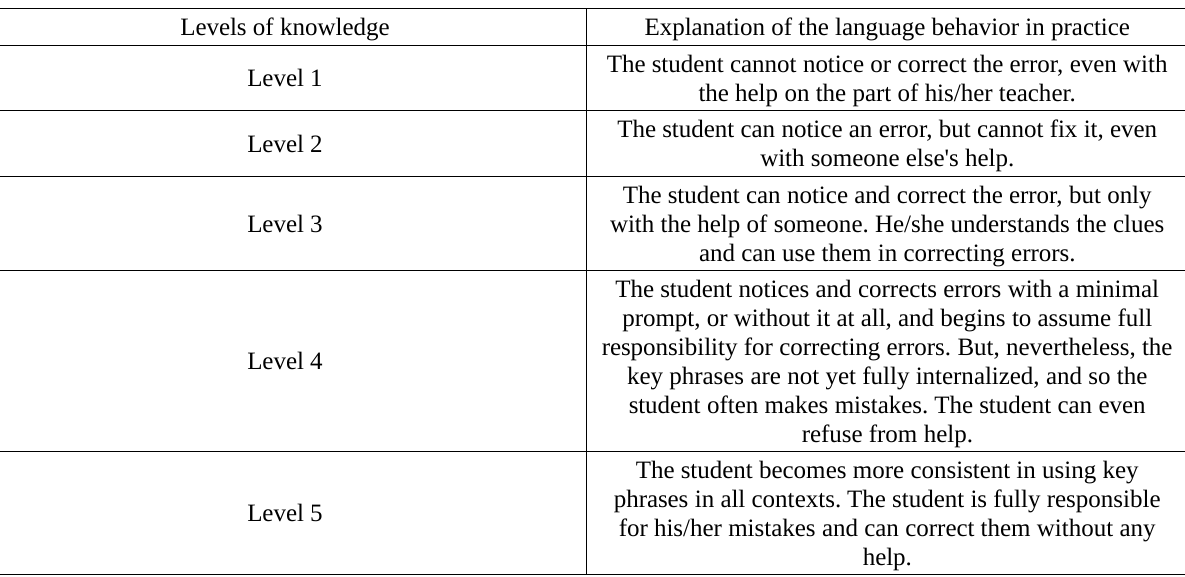
Table 1 - Levels of internalization from interpsychological to intrapsychological language